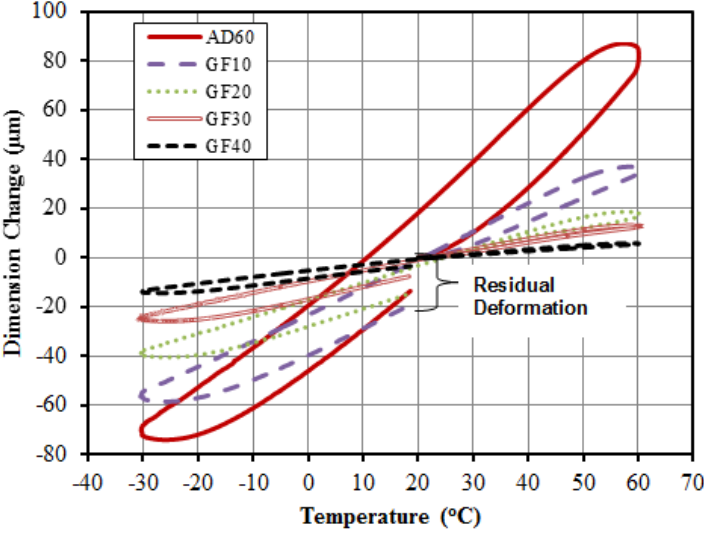
Figure 4. Typical dimension change-temperature history for glass fiber filled HDPE AD60 composite systems.